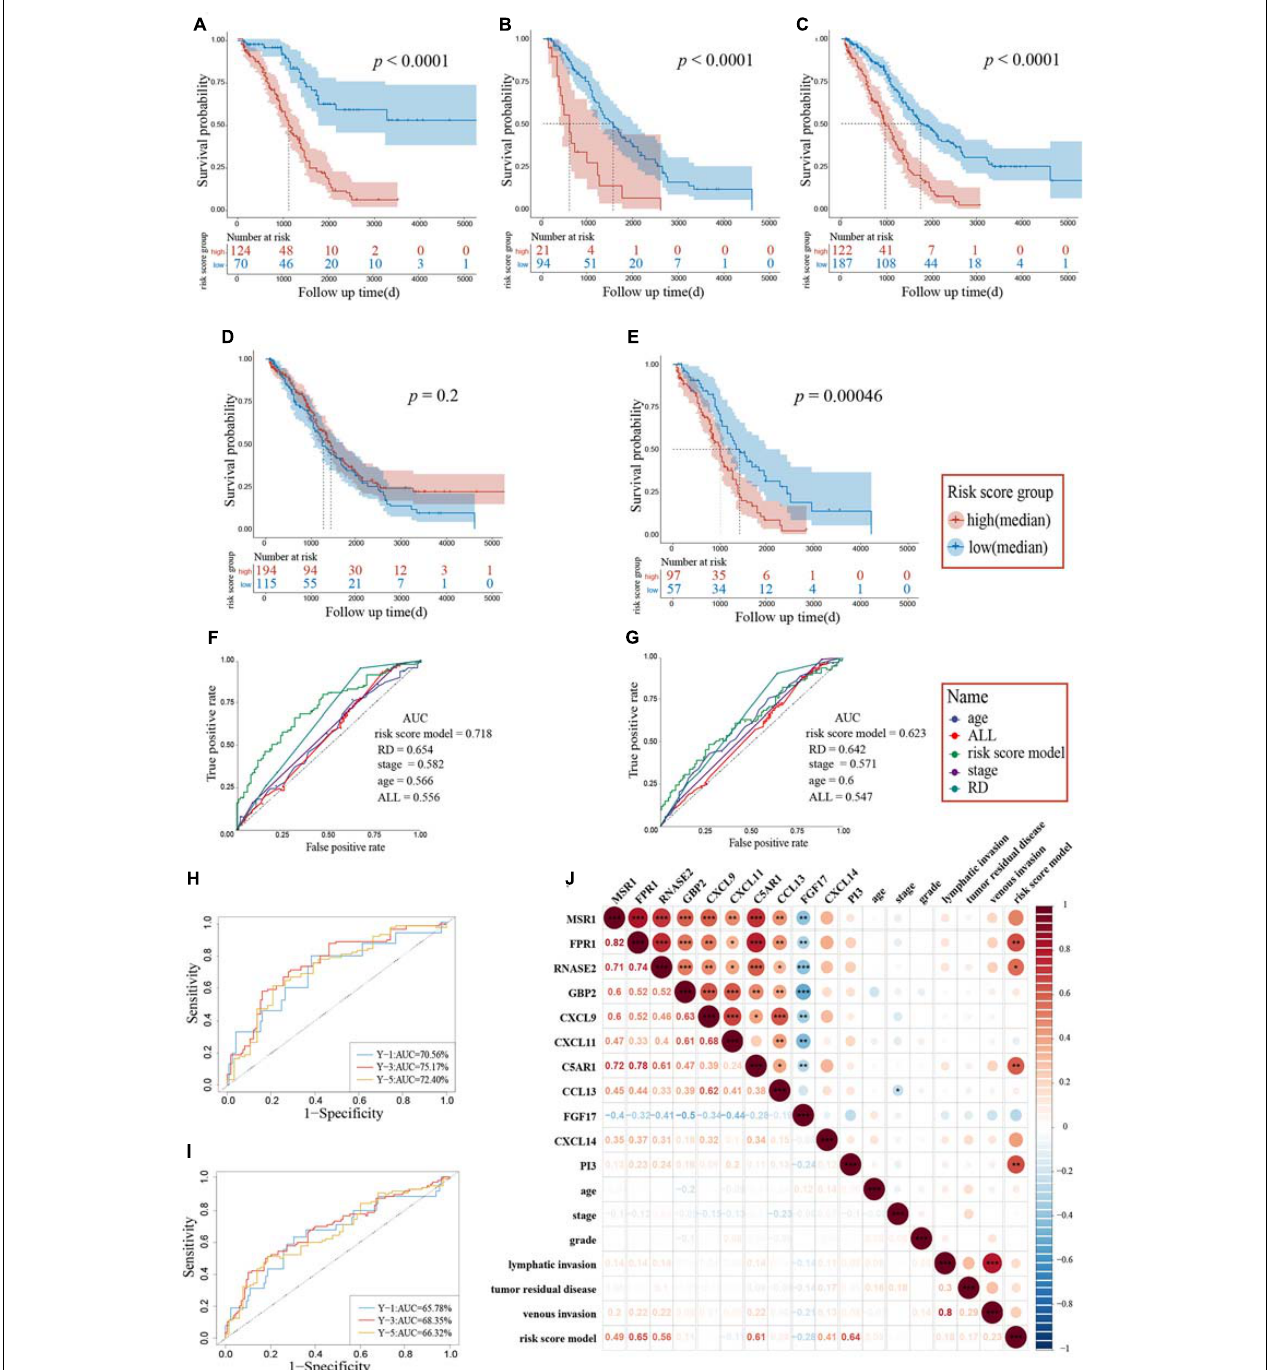
FIGURE 5 | Assessment of candidate immune genes and prognostic capacity. A log-rank test was set up for statistics. Kaplan–Meier survival analysis based on the risk score model in the “Immune High” cluster (A) , the “Immune Low” cluster (B) , and the whole TCGA cohort (C) . Patients grouped by best cutoff values were listed in the risk score chart below at different time points. (D) Kaplan–Meier survival analysis between two immune clusters. (E) Kaplan–Meier survival analysis based on the risk score model between two immune clusters. Patients were grouped by median value in each cluster. ROC and the corresponding AUC of the risk score model and other clinical pathological characteristics for the “Immune High” cluster (F) and the whole TCGA cohort (G) . Time–ROC of the risk score model for the “Immune High” cluster (H) and the whole TCGA cohort (I) . The ROC and AUC of the predictions for 1, 3, and 5 years are shown, respectively. (J) Correlation heatmap of immune genes extracted by LASSO, risk score model, and clinical pathological characteristics. The lower triangular was the correlation coefficients between two variables and the upper triangular matrix was the significant adjusted p values. RD, tumor residual disease; ROC, receiver operating characteristic; AUC, area under the curve; * p < 0.05, ** p < 0.01, *** p < 0.001.